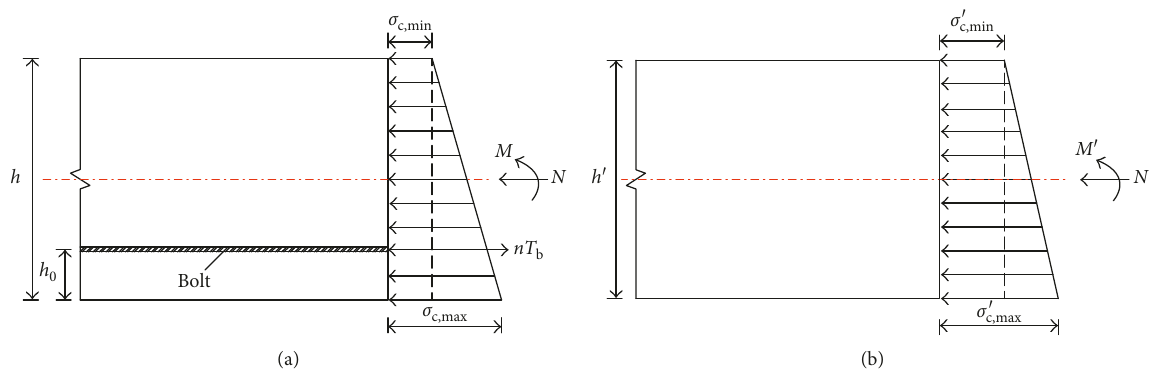
Figure 6: Mechanical characteristic of the joint section under positive bending moment and small eccentricity pressing condition. (a) Original joint section. (b) Equivalent joint